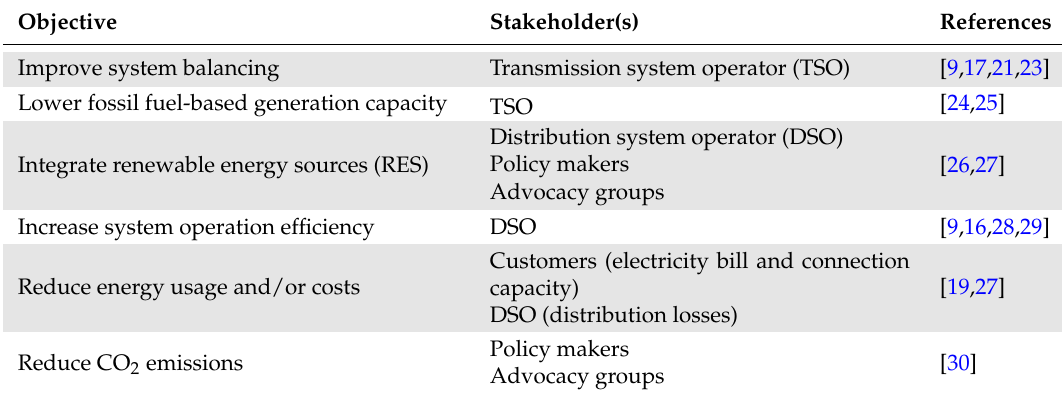
Table 1. Objectives for deploying demand-side